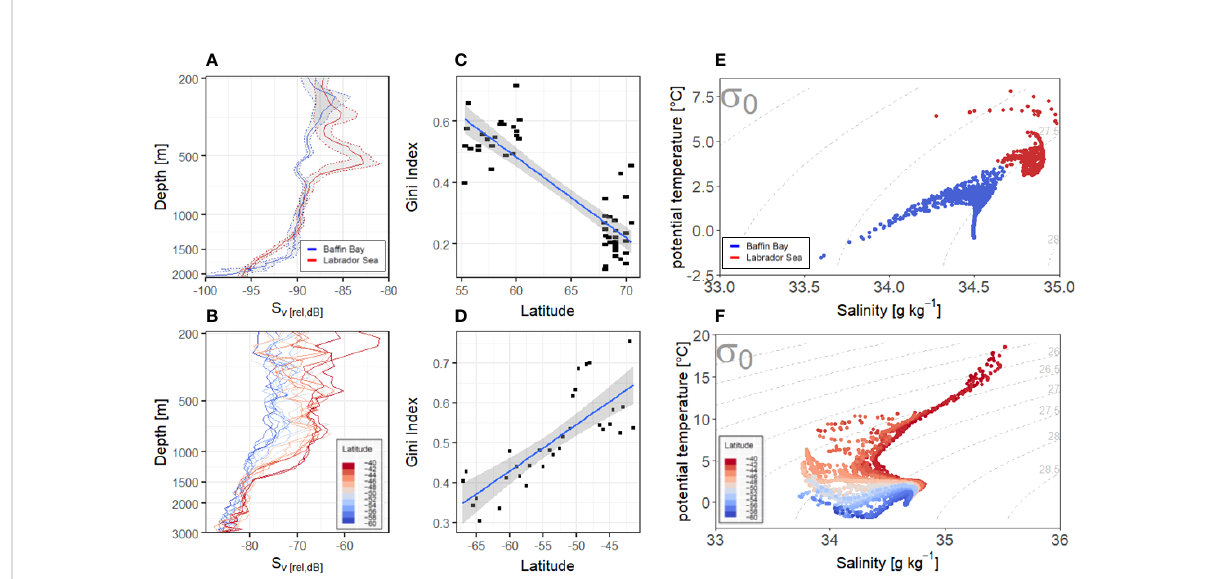
FIGURE 3 LADCP backscatter and Temperature-Salinity plots pro fi les across polar transition zones. 300 kHz LADCP pro fi les from the deep basins of the Labrador Sea in 2018 and 2019 and Baf fi n Bay in 2016 (A) and 150 kHz LADCP pro fi les along the southern transect (30°E line in 2008) across the Polar Frontal Zone (PFZ) (B) . Vertical LADCP pro fi les in the Southern Ocean are presented as average backscatter per decimal degree. Vertical LADCP pro fi les in the Labrador Sea and Baf fi n Bay are presented as averages (solid lines) and 95% con fi dence intervals (dashed lines and grey shading). The corresponding Gini Index between 200 m depth and the sea fl oor for all stations deeper than 1500m along the northern transects (C) and corresponding Gini Index between 200-3000m for all stations in the Southern Ocean (D) . Temperature-salinity diagrams from concurrent measurements in the Canadian Arctic (Baf fi n Bay/Labrador Sea) (E) and the Southern Ocean (F)